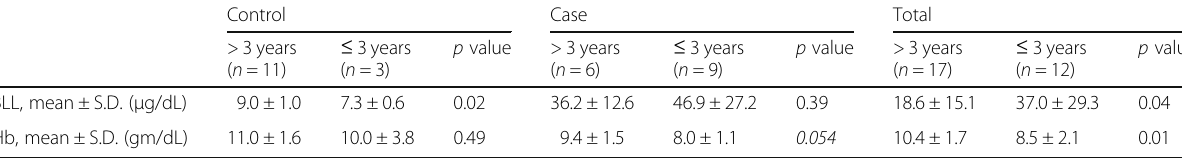
Table 2 Children below 3 years of age show significantly greater anemia for similar BLL among cases ( n = 15) Control